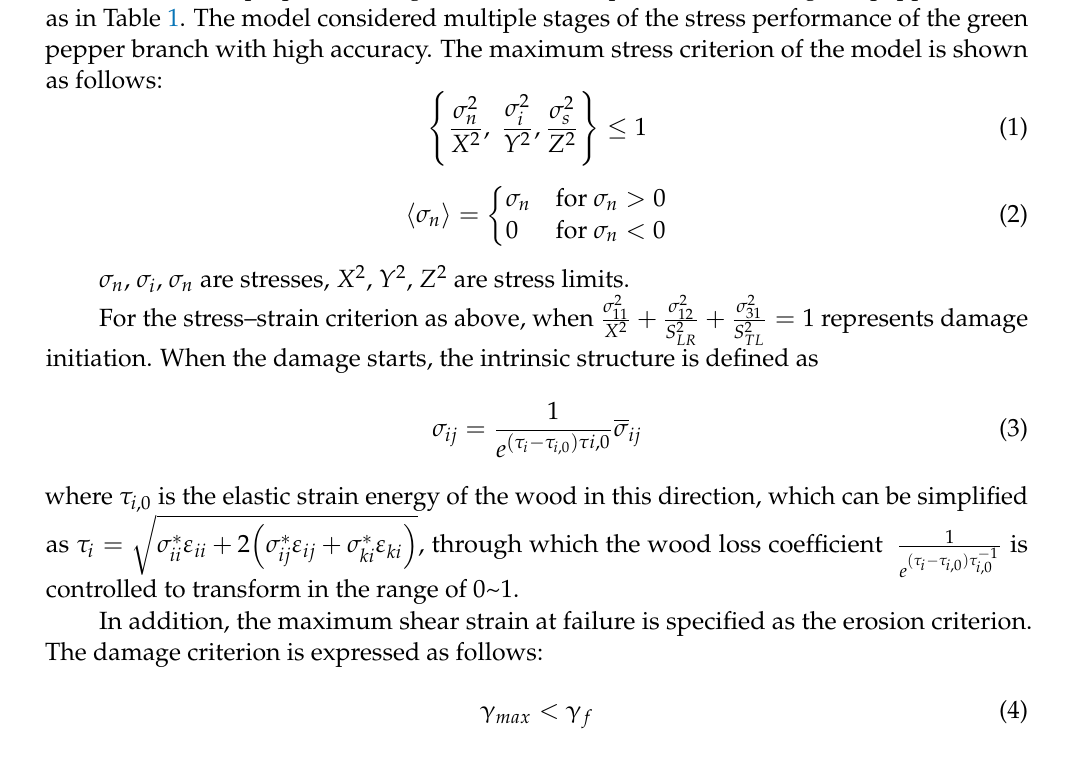
Figure 2. Schematic diagram of the finite element cutting model assembly and boundary condi- tions.